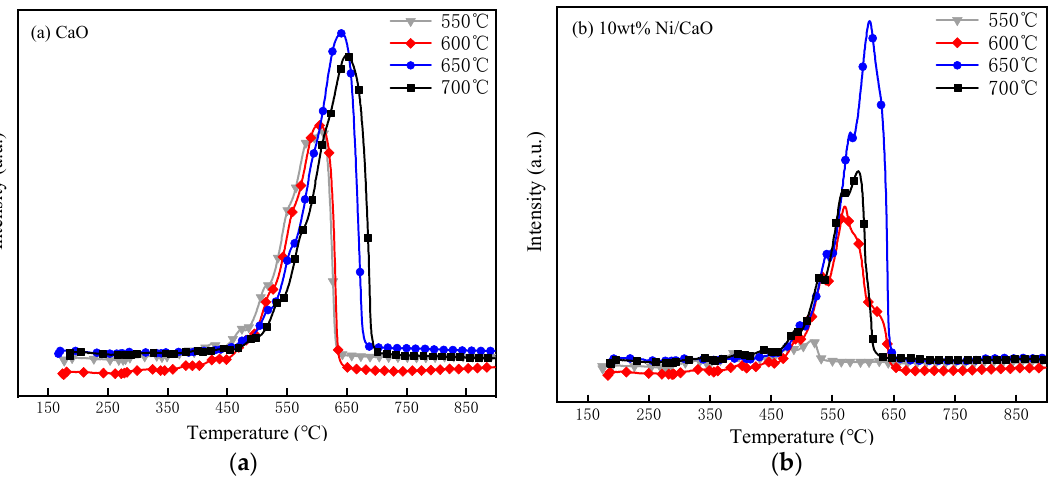
Figure 3. CO 2 -TPD results of the examined catalysts: ( a ) the CO 2 -TPD results of the CaO catalysts; ( b ) the CO 2 -TPD results of the CaO catalysts.